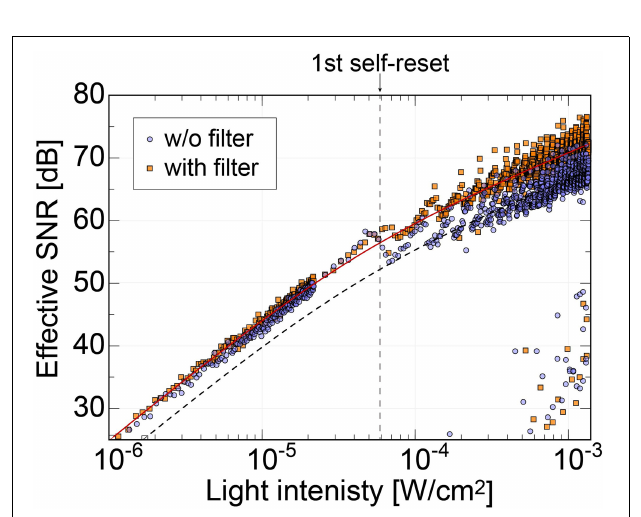
FIGURE 8 | (A) SNR of the pixel with N-well/P-sub photodiode, (B) SNR of the pixel with P+/N-well/P-sub photodiode.